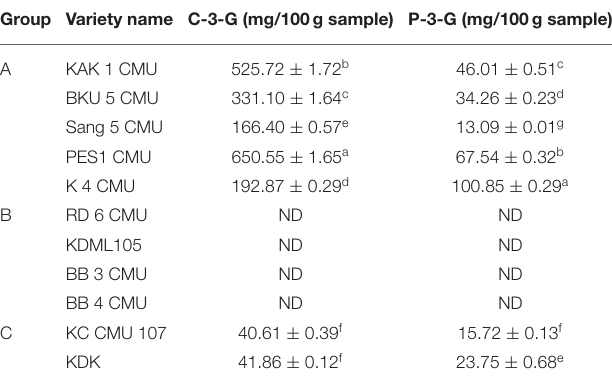
TABLE 5 | The anthocyanins content in rice bran